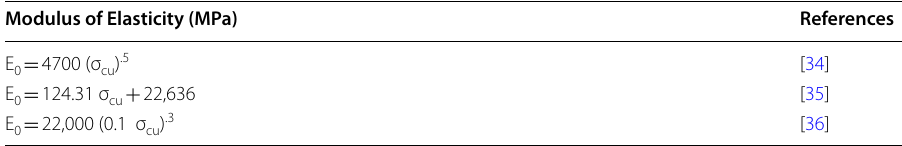
Table 2 Approximate value for concrete initial modulus of elasticity Modulus of Elasticity